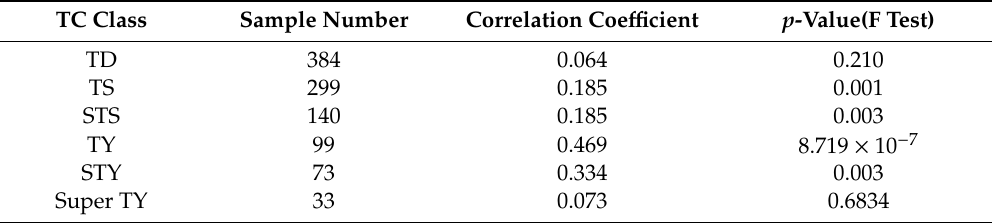
Table 3. Correlation between warm core strength and wind speed for the same TC intensity.